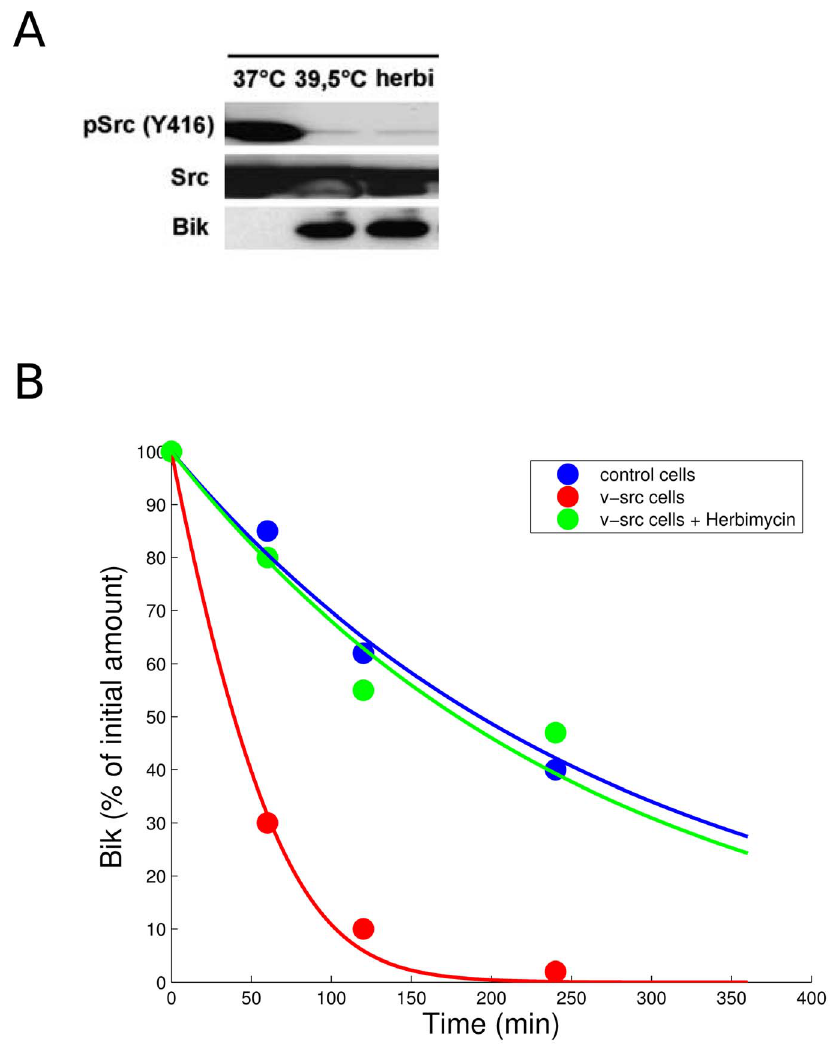
Figure 2. Estimating Bik degradation rates in control and Src-transformed cells. A Endogenous Bik level was compared with Src level and Src kinase activity as monitored by Y416 phosphorylation in Src-transformed cells. v-Src kinase activity was inhibited either by herbimycin or by incubation at 39.5 u C. Src inhibition by herbimycin was quantified to 98%. Reprinted with permission from [5] B Bik degradation was monitored in parental and Src-transformed cells. v-Src kinase activity was inhibited by herbimycin in transformed cells. Dots are experimental results reprinted from [5]. Solid lines represent the best fit of Bik kinetics mathematical model (Equations 1 and 2). See Results for parameter values.